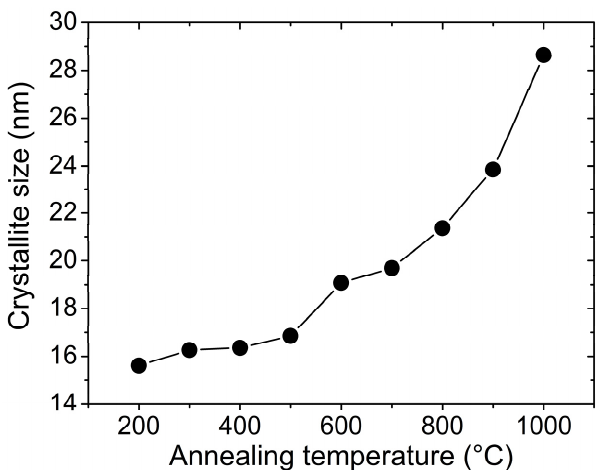
Figure 4. Crystallite size as a function of the ZnAl 2 O 4 powders’ calcination temperature.